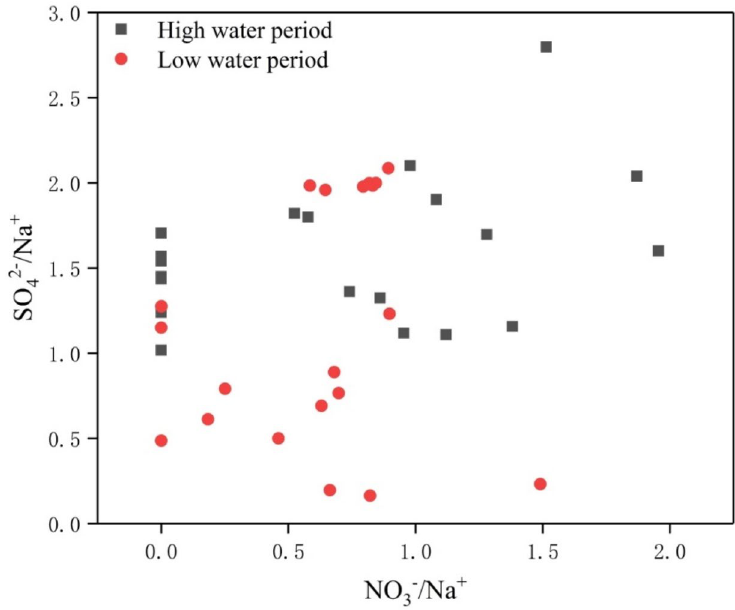
Figure 7. The relationship between SO 4 2− /Na + and NO 3 − /Na + during high (grey squares) and low (red circles) water periods in the tributaries of the Xijiang